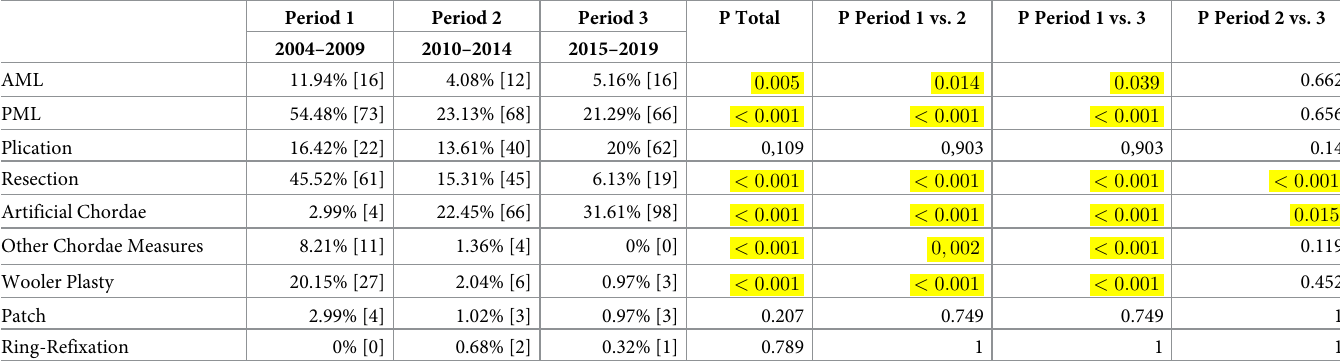
Table 3. Types of additional repair maneuvers.